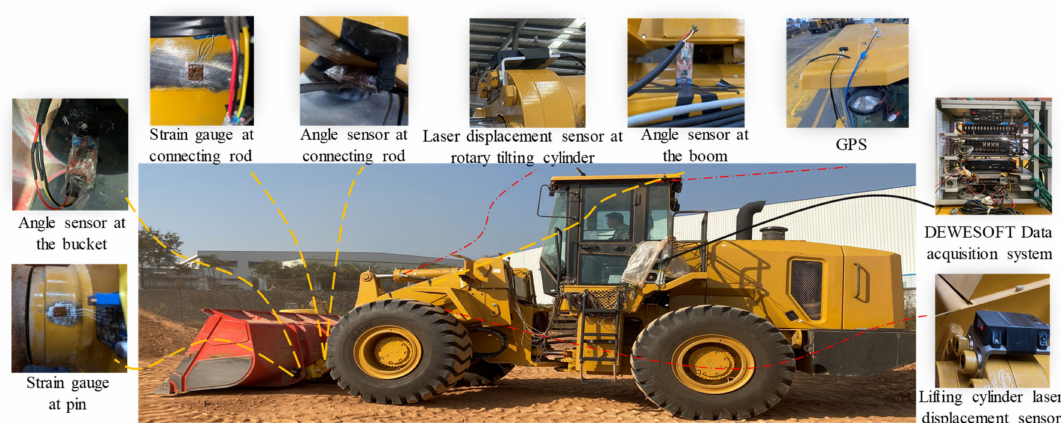
Figure 6. The layout of the sensors installed on the wheel